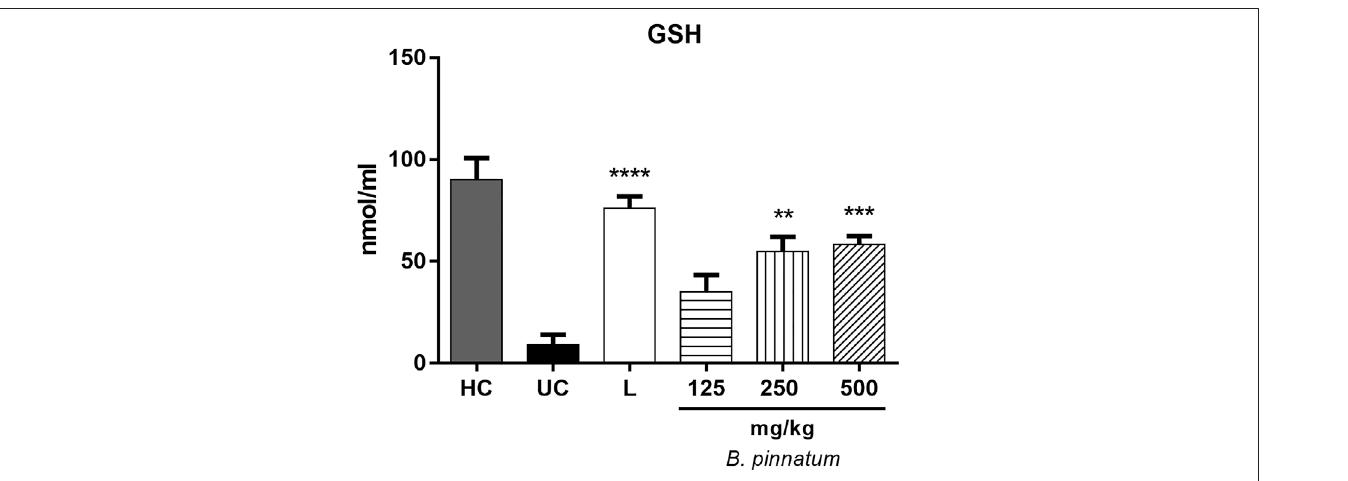
FIGURE4| Effectoftreatmentwith B.pinnatum leafextract(125,250,and500 mg/kg)onGSHlevelsintheaceticacid – inducedchronicgastriculcermodelinrats. Resultsexpressedasmean ± standardmeanerror( n (cid:2) 6).ANOVAandTukeypost-testwereusedtocalculatethestatisticalsigni fi cance,** p < 0.01,*** p < 0.001,**** p < 0.0001 vs. ulcerated control. Healthy control, HC; ulcerated control, UC; lansoprazole (30 mg/kg), L.